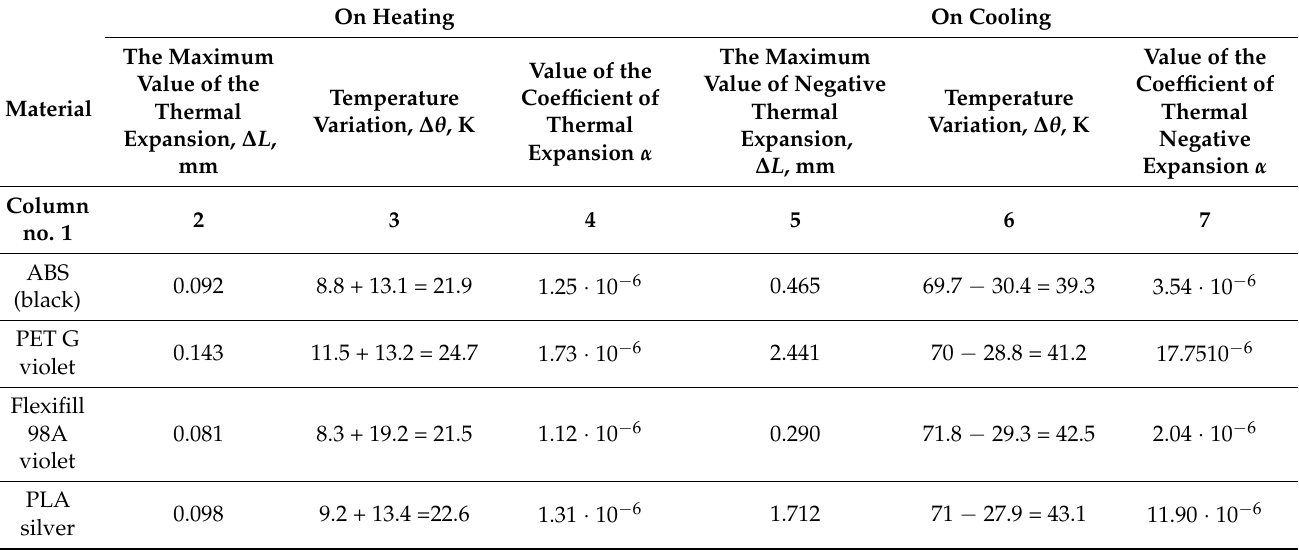
Figure 6. The evolution in time of negative thermal expansion of some spiral specimens made of polymeric materials, there being small differences between the initial temperatures. Table 4. Calculated values of the thermal and negative thermal expansion coefficients, considering the experimental results presented in Tables 2 and